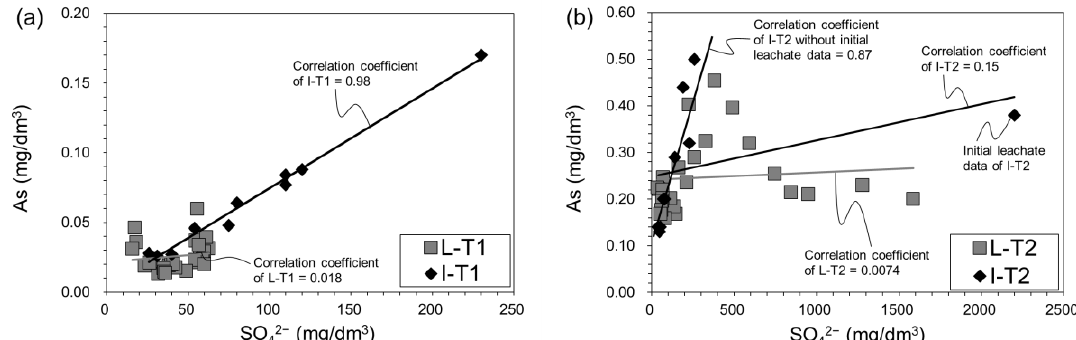
Figure 10. Correlation between As and SO 42− concentrations; ( a ) comparison between L-T1 and I-T1 and ( b ) comparison between L-T2 and I-T2. Correlation coefficients of L-T1, I-T1, L-T2 and I-T2 are equal to 0.018, 0.98, 0.0074 and 0.15, respectively, whereas that of I-T2 without initial leachate data is 0.87.